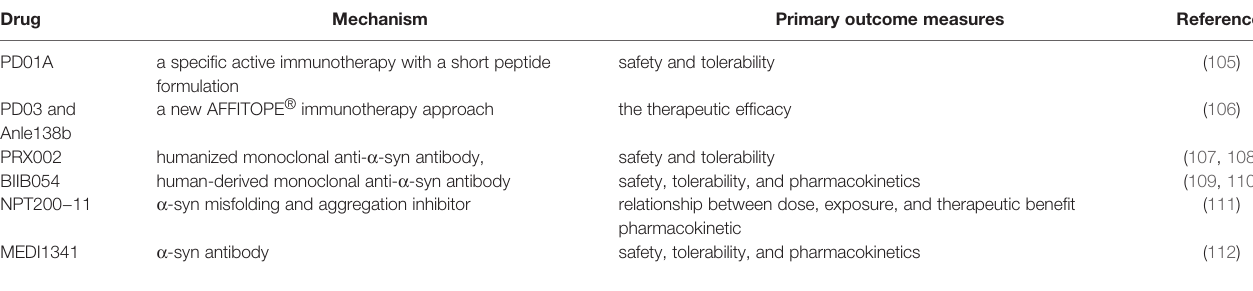
TABLE 1 | Drugs targeting a -syn tested in clinical